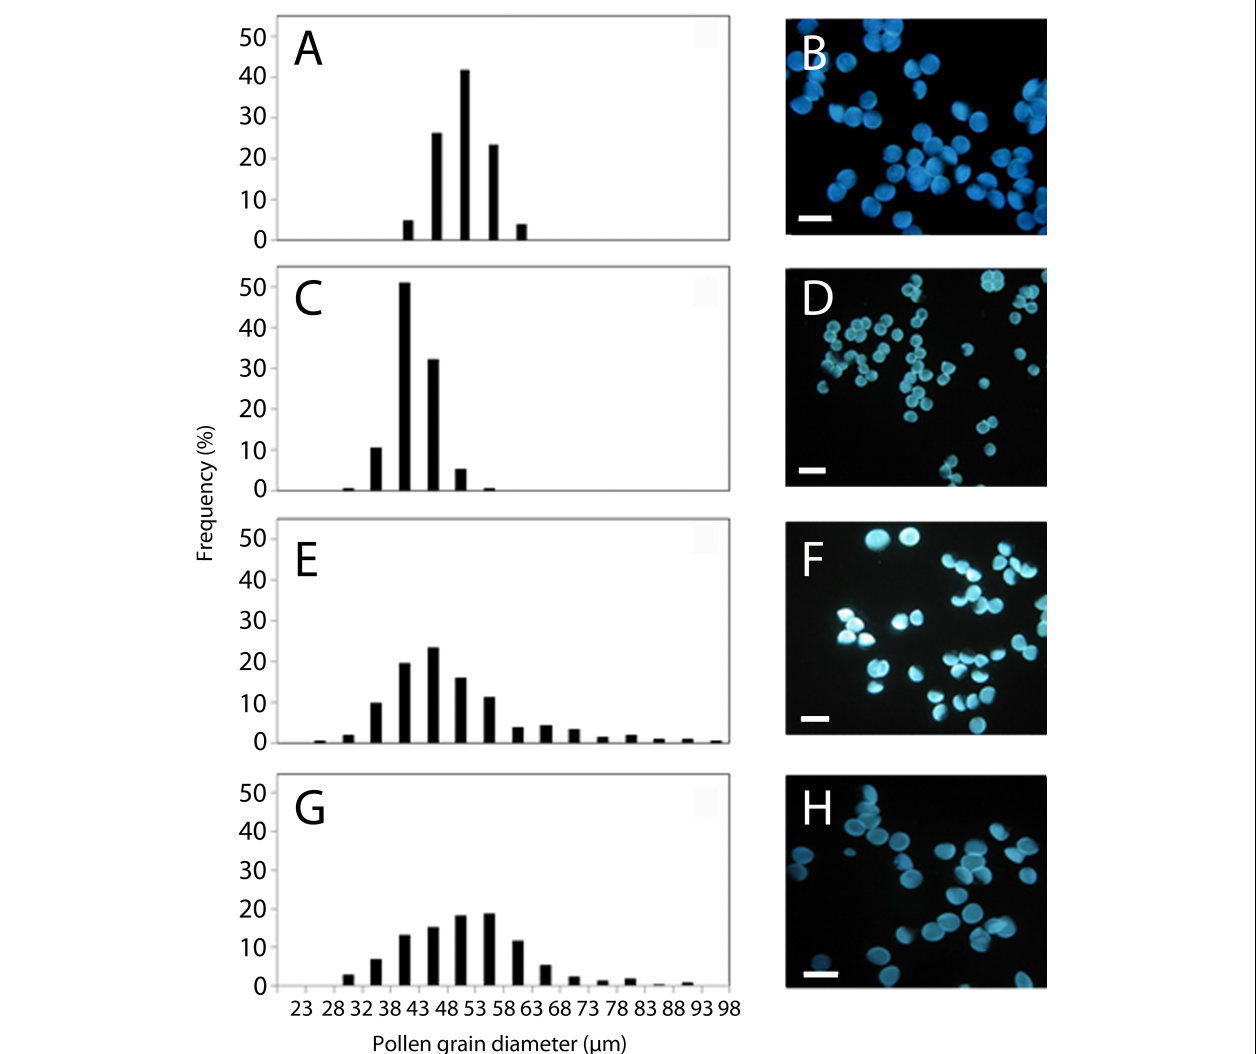
FIGURE 3 | Frequency distribution and images showing the heterogeneity of pollen diameters in the parental genotypes, Annona cherimola cv. Fino de Jete, “Fj” (A,B) and Annona squamosa , Thai seedless “Ts” (C,D) , in the FT148 hybrid diploid (E,F) and in the FT6 hybrid triploid (G,H) from the interspecific cross between A. cherimola × A. squamosa . Scale bars, 10 µ m.